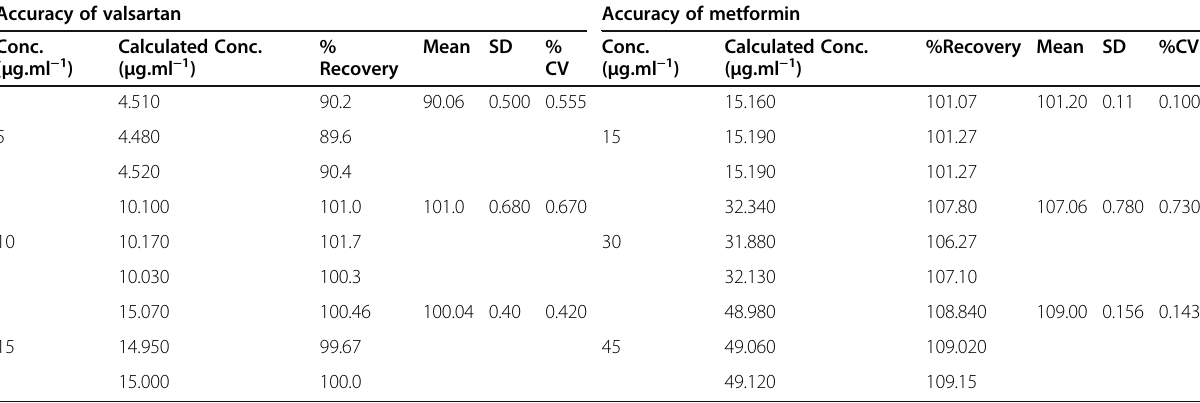
Table 3 Accuracy: valsartan-metformin Accuracy of valsartan Accuracy of metformin Conc. ( μ g.ml − 1